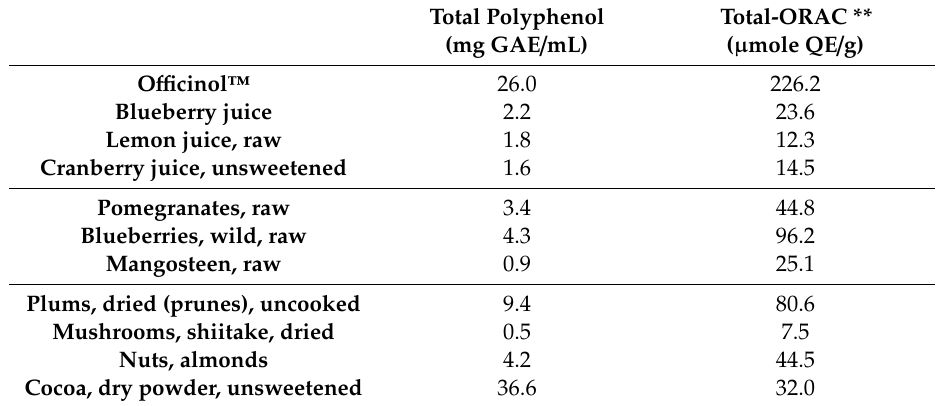
Table 4. Polyphenol content and antioxidant activity of O ffi cinol ™ vs. other natural fruits and nuts